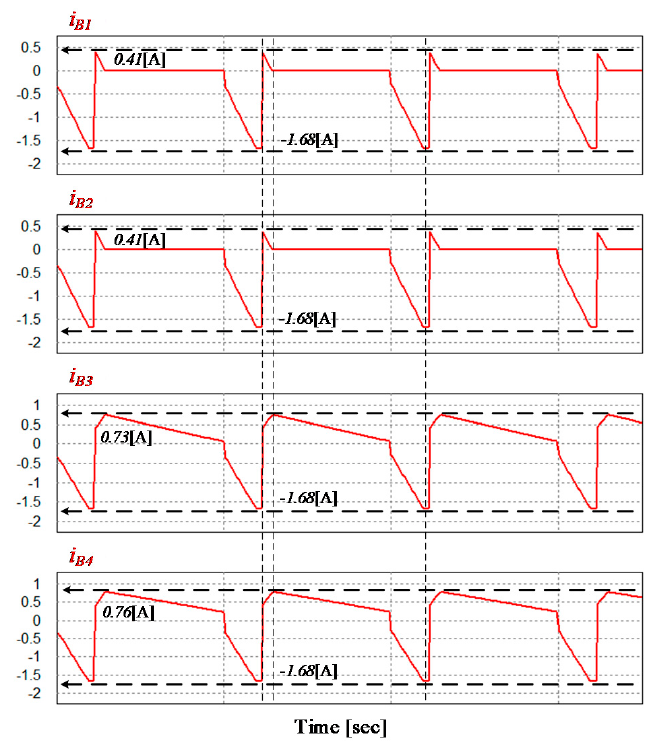
Figure 12. Simulation results of the proposed circuit in various conditions: ( a ) standalone condition, ( b ) charging condi- tion, and ( c ) discharging condition.